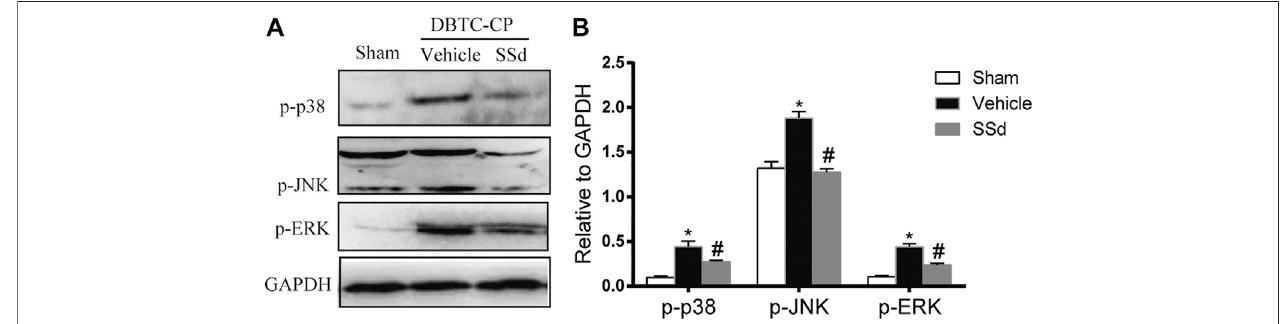
FIGURE 3 | SSd inhibited the phosphorylation activation of MAPK family proteins in DBTC-induced CP. Western blot analysis of p-JNK, p-ERK 1/2, and p-p38 MAPK. ( n (cid:1) 6 – 8, p p < 0.05 vs. Sham group; # p < 0.05 vs. CP group).